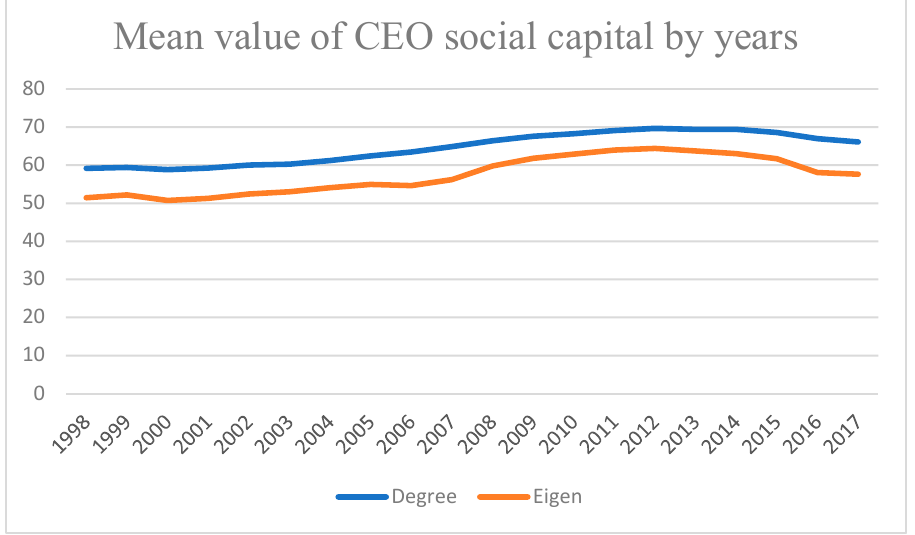
Figure 4. Mean value of CEO social capital by years.